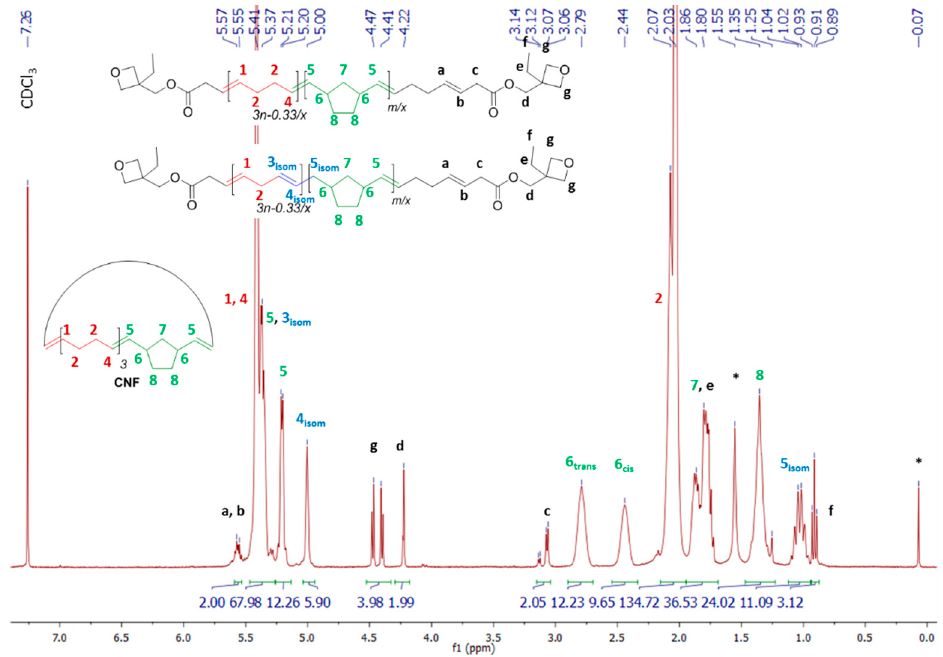
Figure 3. 1 H NMR spectrum (500 MHz, CDCl 3 , 25 °C) of an α , ω -dioxetane telechelic P(NB- co -CDT) copolymer sample that was prepared by ROMP/CM of an equimolar mixture of NB/CDT in the presence of G2 /CTA 3 in CH 2 Cl 2 (Table 3, entry 8) (* δ (ppm) 1.55 residual H 2 O, 0.07 residual grease).